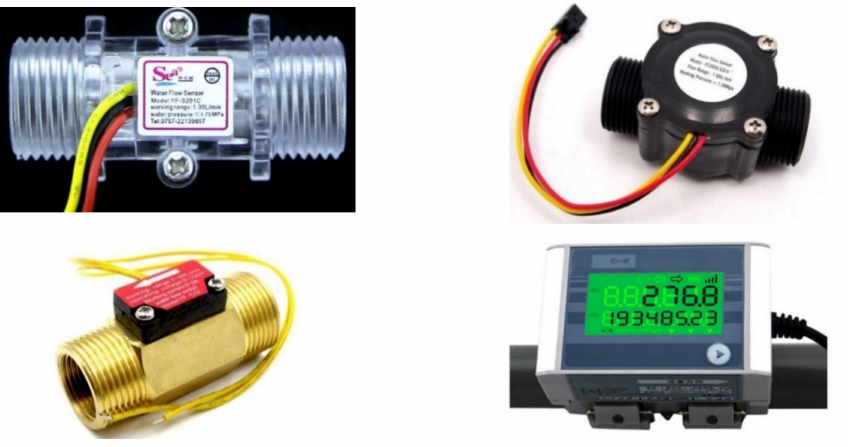
Figure 9. Some typical flow sensors [75,113], Courtesy of the Hunan Mac Sensor Co., Ltd., China; and Ningbo Mingrui Zhongxing Electronics Technology Co., Ltd.,